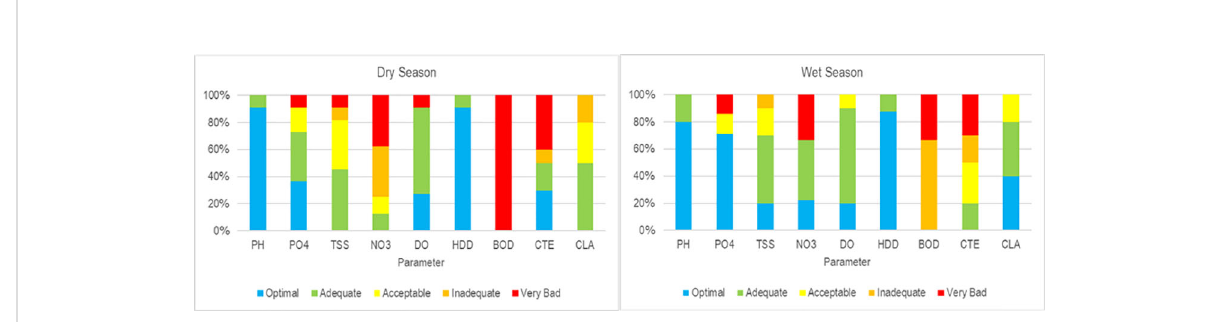
FIGURE 8 Proportion of measurements from each measured parameter by quality category. Source: Adapted from INVEMAR - REDCAM